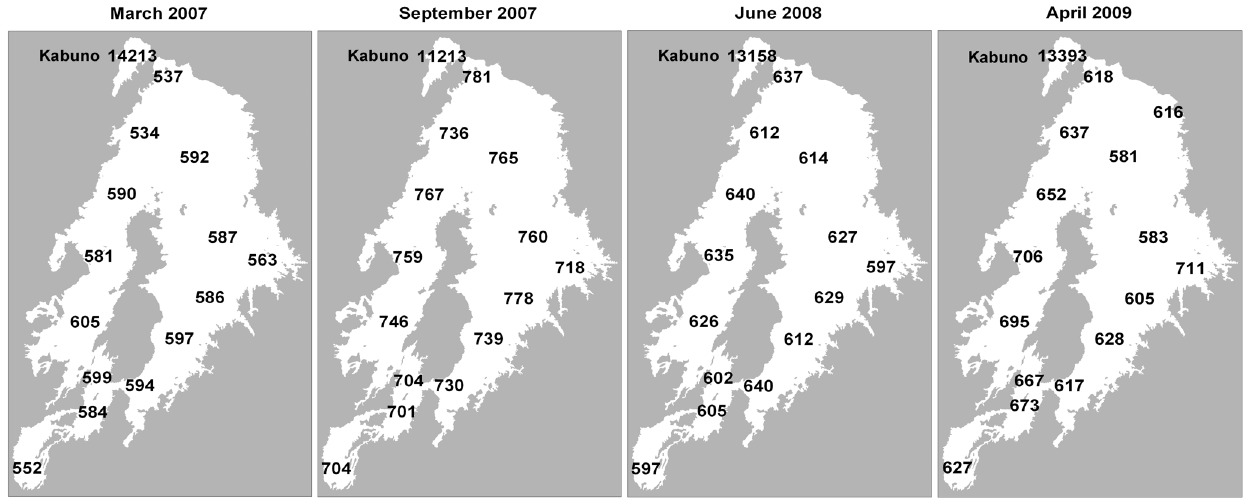
Figure 2. Spatial distribution of the partial pressure of CO 2 (pCO 2 , ppm) in the surface waters of Lake Kivu (1 m depth) in March 2007, September 2007, June 2008 and April 2009.